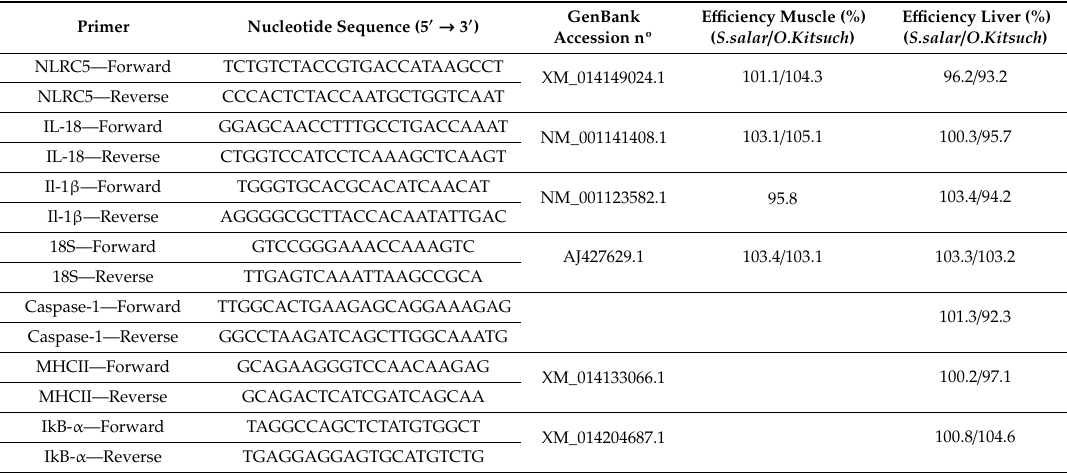
Table 1. Primer sequences for qPCR used in the experiments. Primer Nucleotide Sequence (5 (cid:48) → 3 (cid:48) )